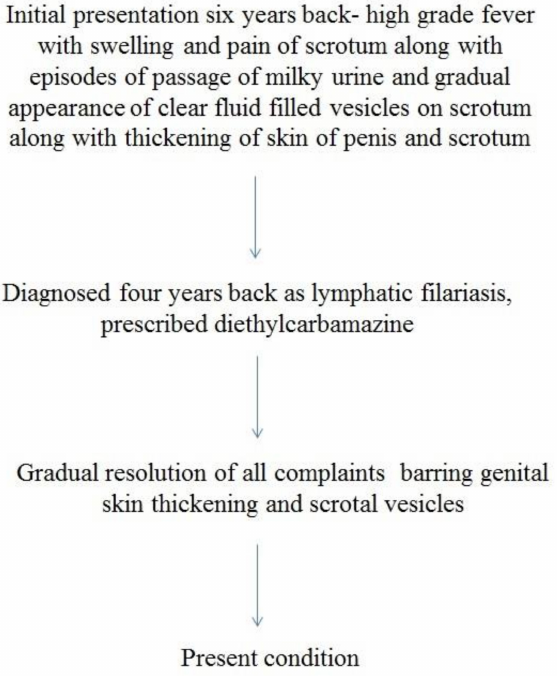
Figure 1. Timeline of patient’s